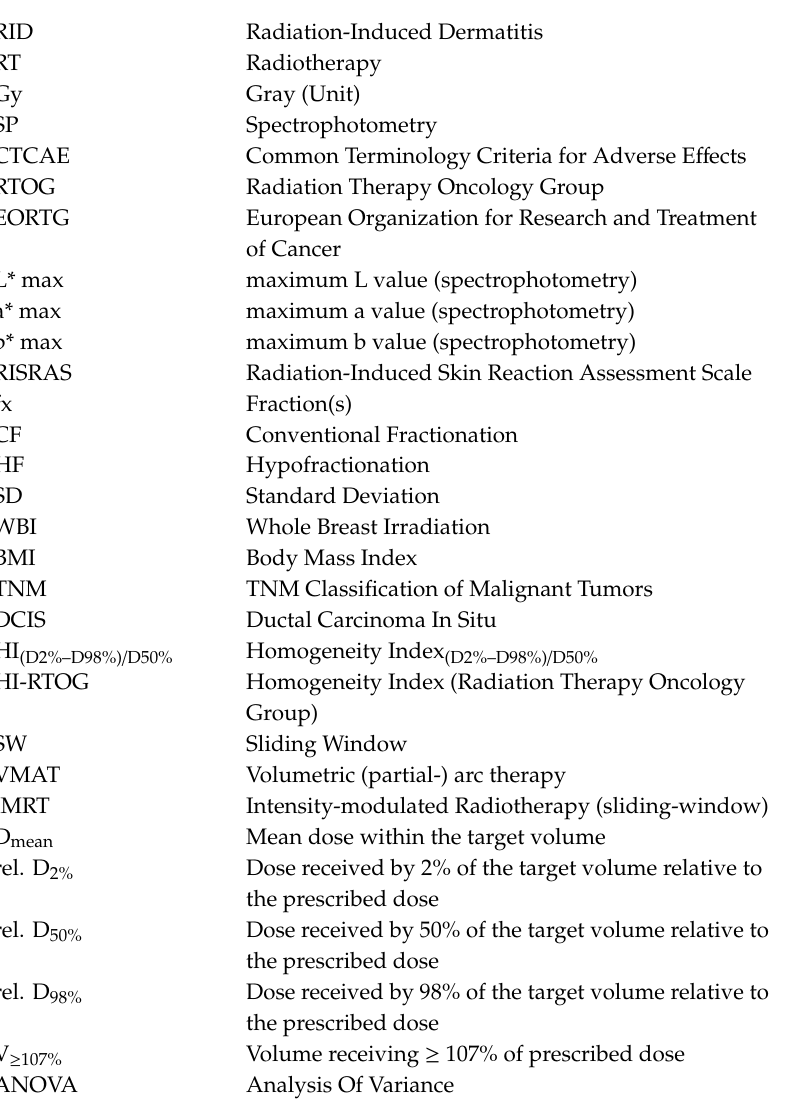
Figure S1: Skew value-to-e ff ect distribution pattern for breast volume and maximum a*